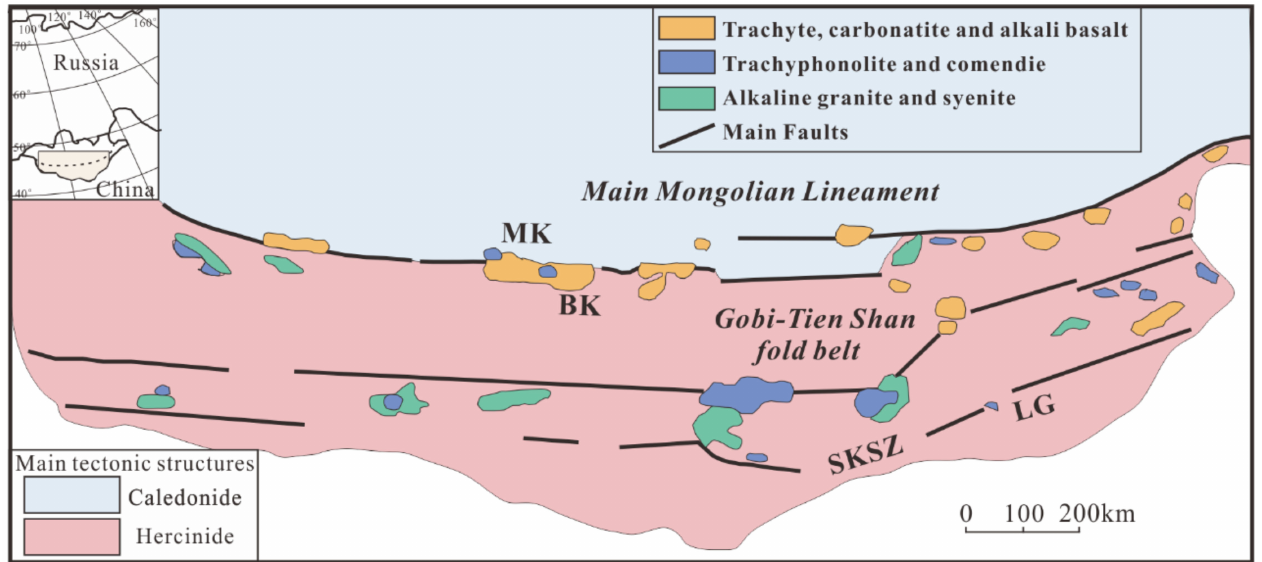
Figure 1. Locations and simplified geological map of the Mushgai Khudag complex modified from Baatar et al. [6]. MK = Mushgai Khudag, BK = Bayan Khoshuu, SKSZ = Sulinkheer suture zone, LG = Lugiin